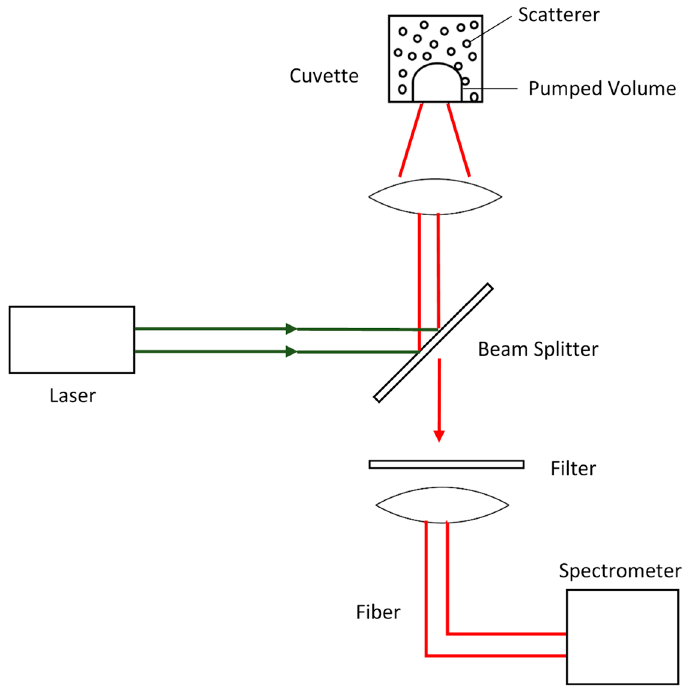
Figure 1. Optical layout of random lasers.